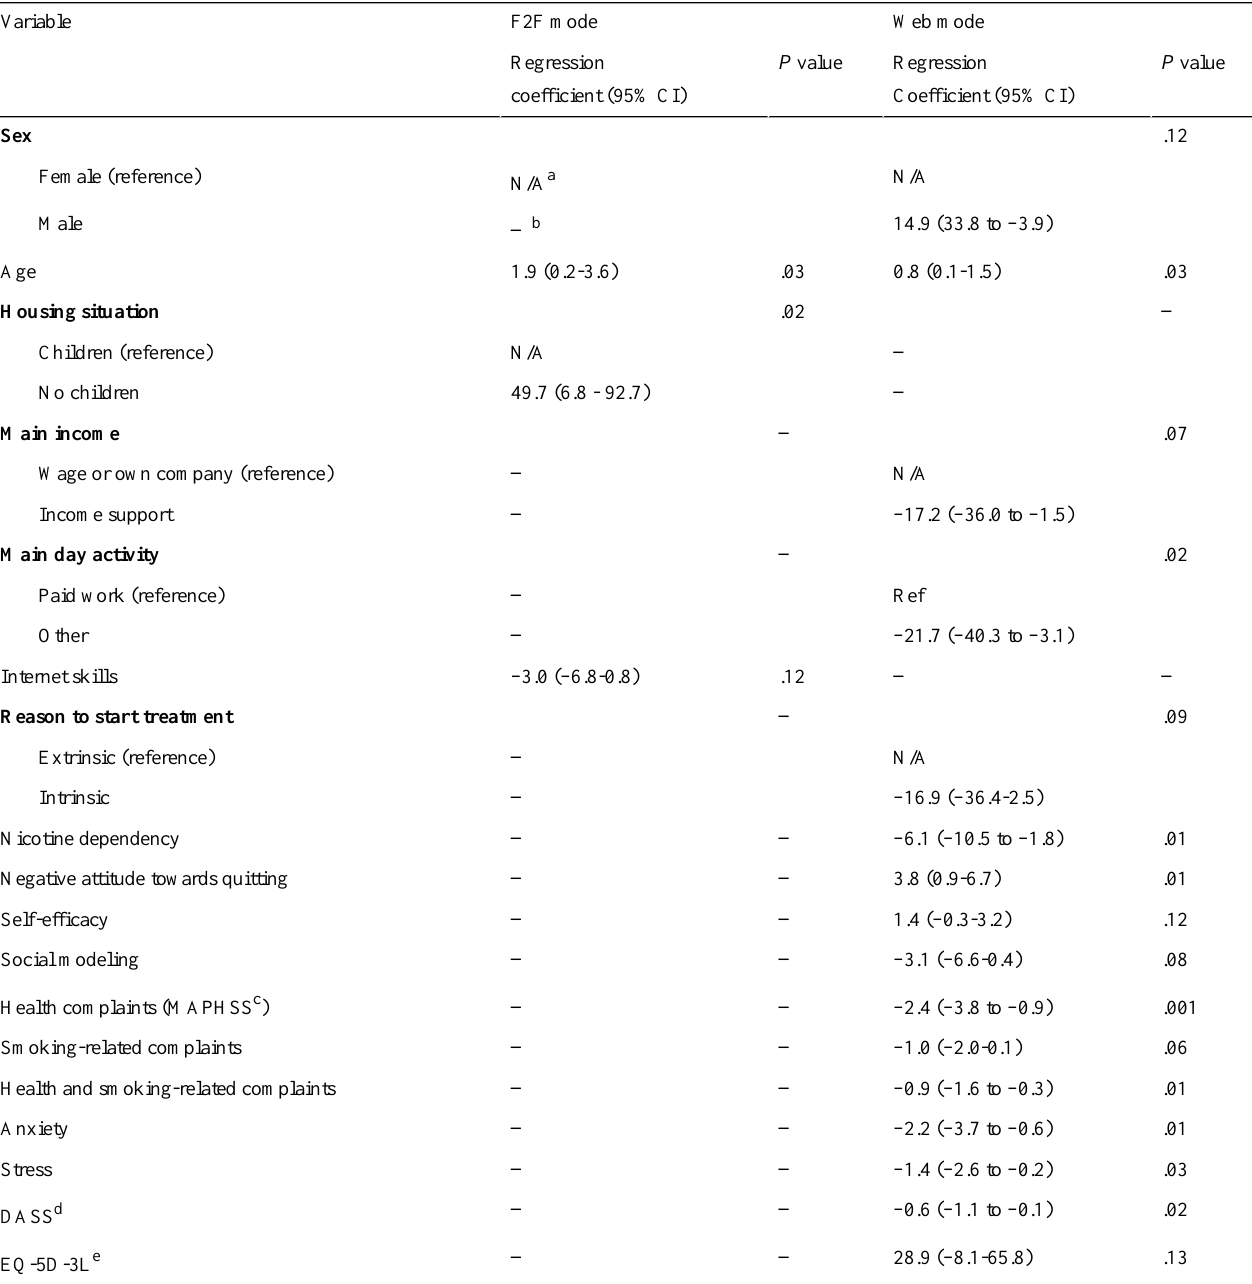
Table 6. Univariate predictors for adherence to face-to-face (F2F) mode and web mode in the blended treatment